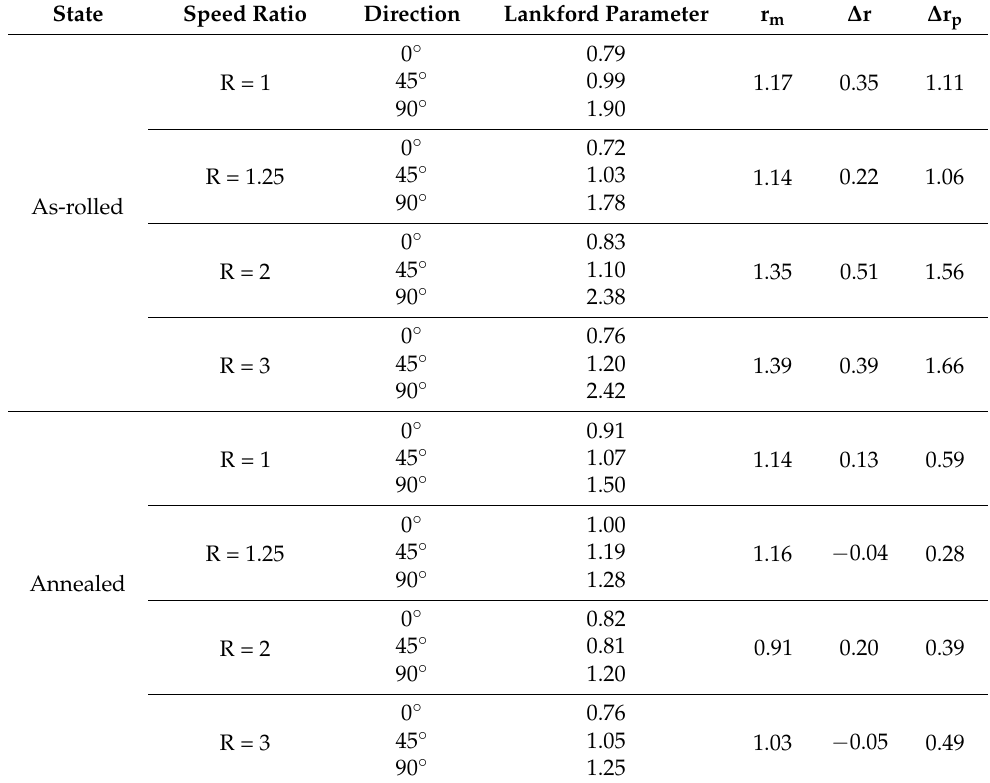
Table 3. Normal anisotropy r m , planar anisotropy ∆ r and earing tendency ∆ r p of the as-rolled and annealed Mg-6Sn sheets processed with different speed ratio. State Speed Ratio Direction Lankford Parameter r m ∆ r ∆ r p 0 ◦ R = 1